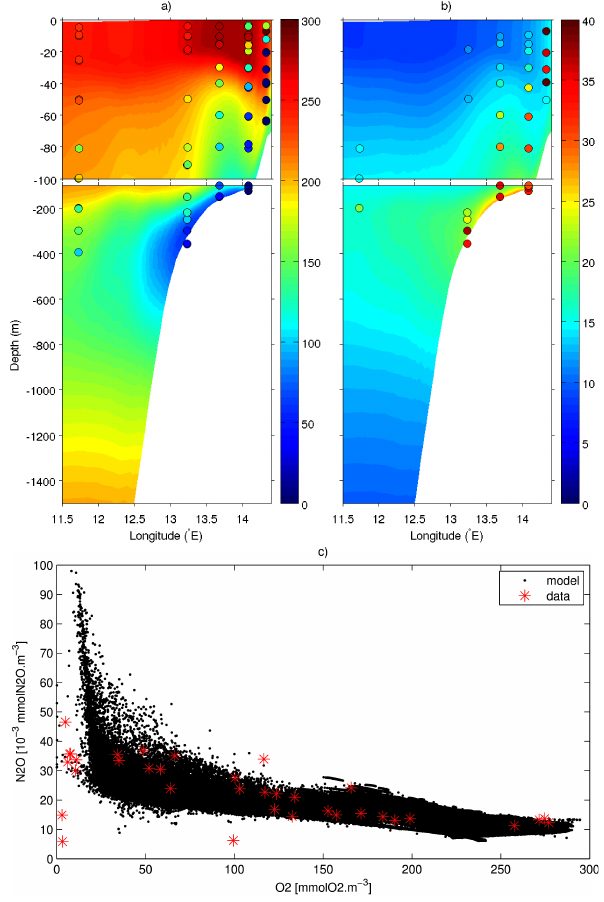
Fig. 9. (a) Oxygen (mmol O 2 m − 3 ) , and (b) nitrous oxide (10 − 3 mmolN 2 Om − 3 ) concentrations estimated with the coupled model at 23 ◦ S (averaged December over 8yr) between the surface and 1500m depth, with a zoom in the first 100m depth. Colored cir- cles for the FRS Africana (December 2009) data are overlaid on the modeled fields using the same color bar. (c) Nitrous oxide concen- trations (10 − 3 mmolN 2 Om − 3 ) as a function of oxygen concentra- tions (mmolO 2 m − 3 ) at 23 ◦ S. Black dots represent the simulated 3-day averaged fields for the whole analyzed period (Y12–Y19), and red stars in situ measurements from the FRS Africana cruise in December